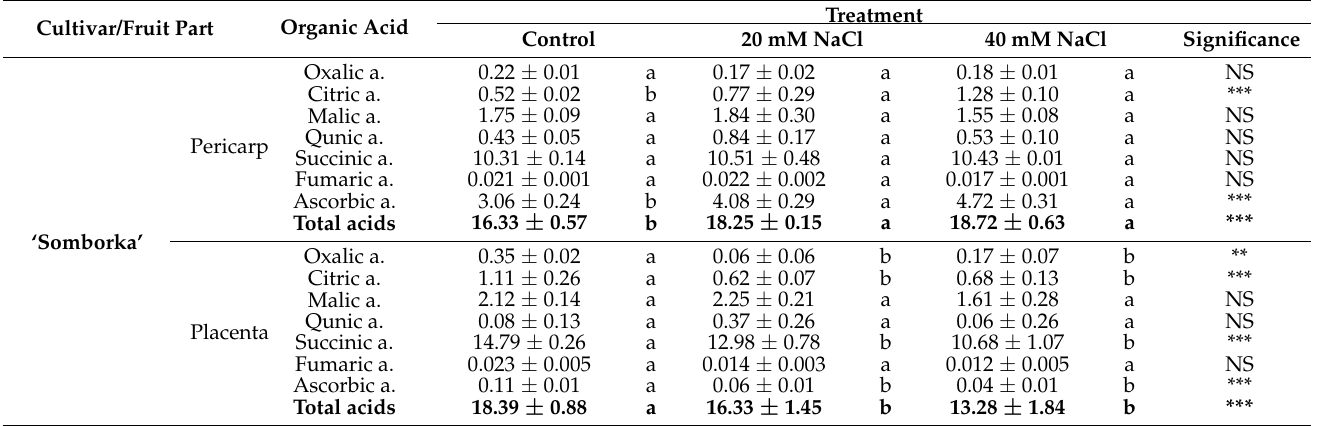
Table 2. Individual and total organic acid contents (g 100 g − 1 DW mean ± SE) of three fruit parts of the four pepper ( Capsicum annuum L.) cultivars under salt